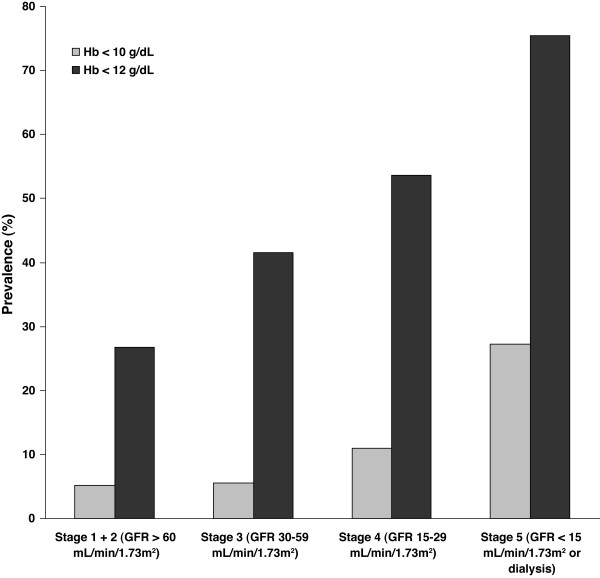
Prevalence of anemia severity stratified by stage of chronic kidney disease. Adapted from McClellan et al., 2004 [3].